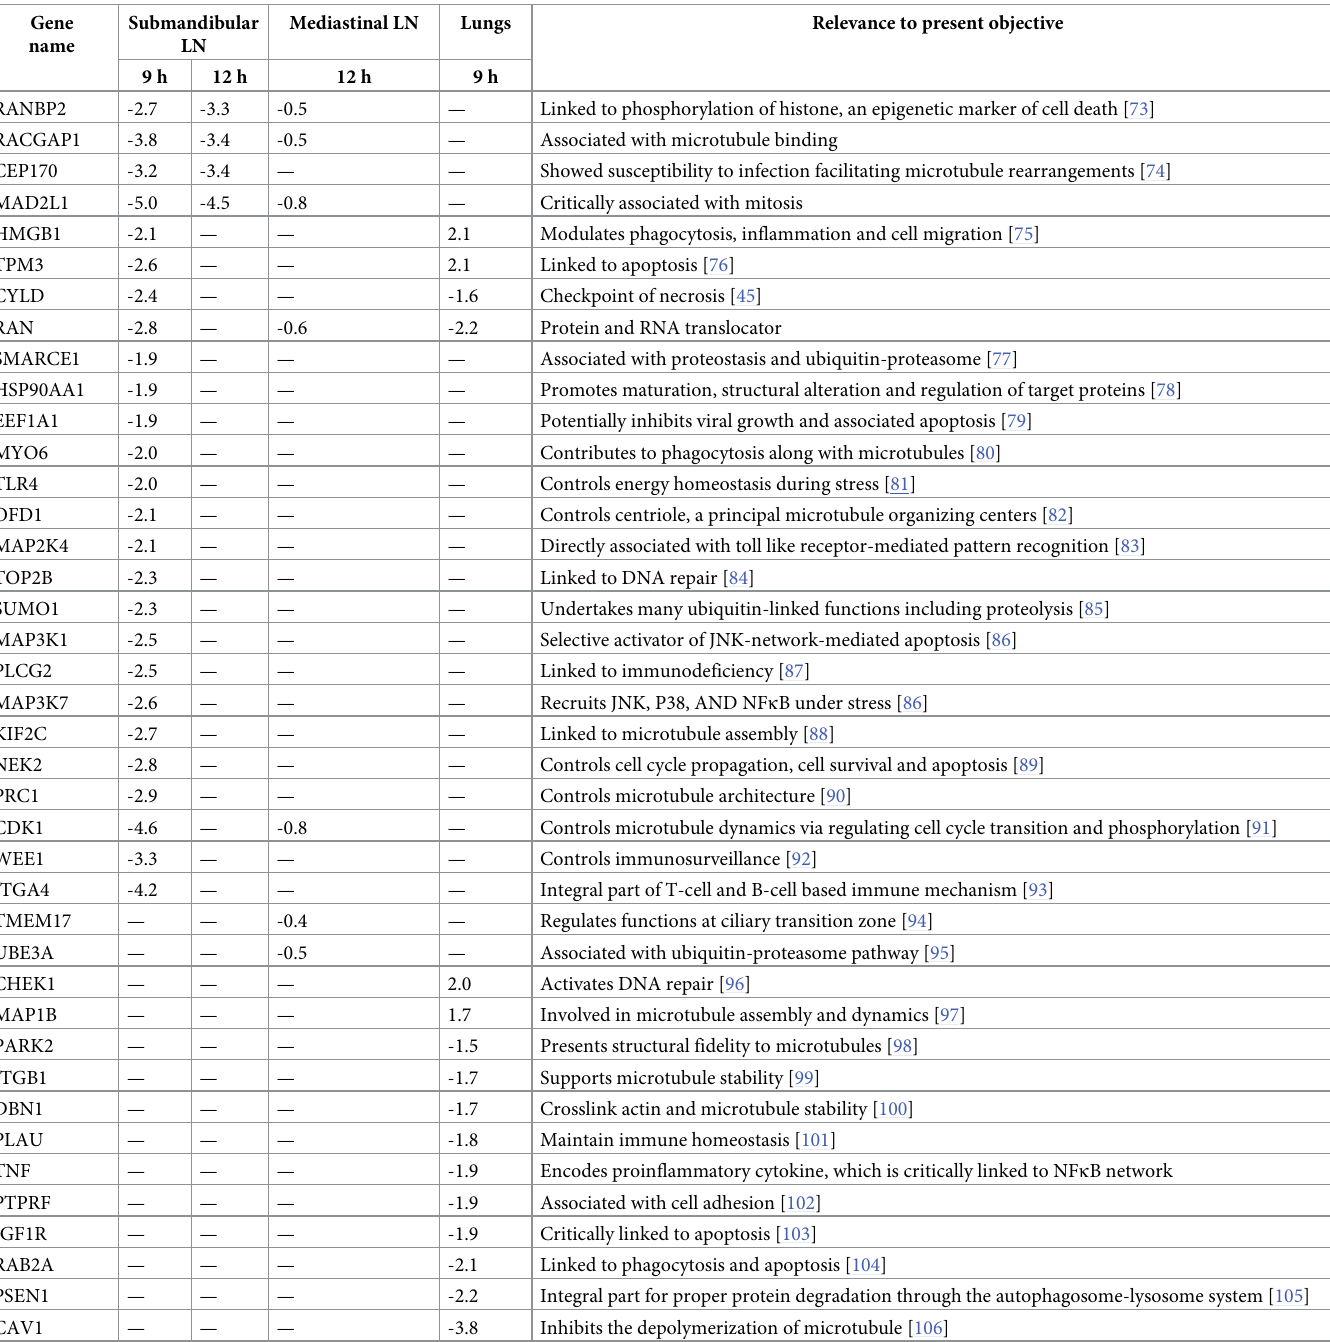
Table 4. Genes of interest from the microtubule network. Listed genes are from the pool ranked in the top tier of the Gene Interaction Hierarchy (GIH). Genes showing early response for at least two early time points (9 h and 12 h p.i.) are listed. Only the significant values (Log 2 values) are reported. Gene Submandibular name